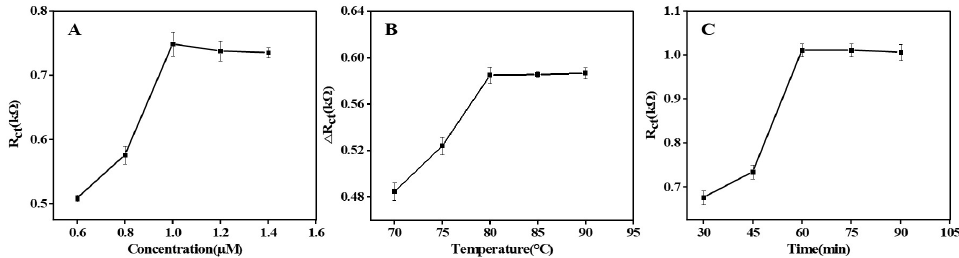
Figure 3. Optimization of the experimental conditions. ( A ) The concentration of locked nucleic acid. ( B ) Melting temperature of locked nucleic acid and aptamer. ( C ) Incubation time of SE.